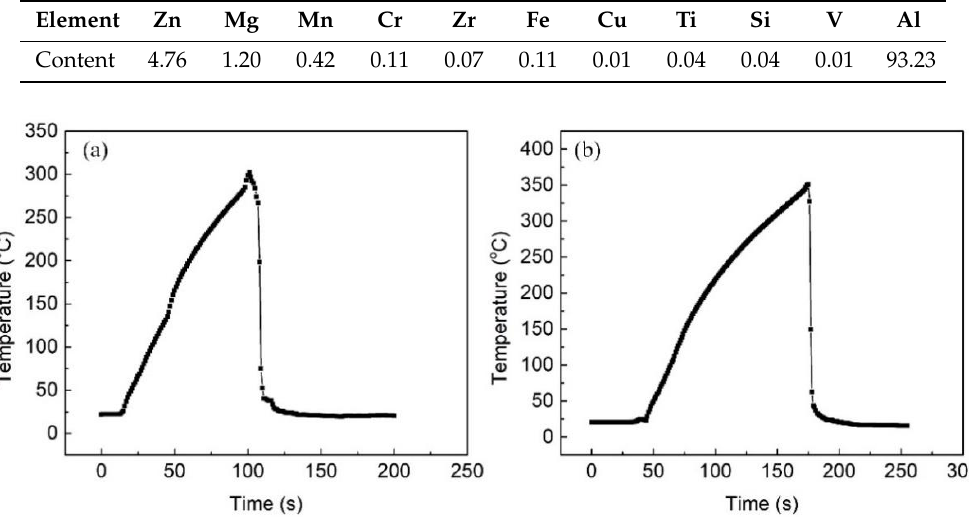
Figure 1. The thermal cycle curves of 7N01 aluminum alloy under water quenching after ( a ) 300 °C and ( b ) 350 °C heat treatment.